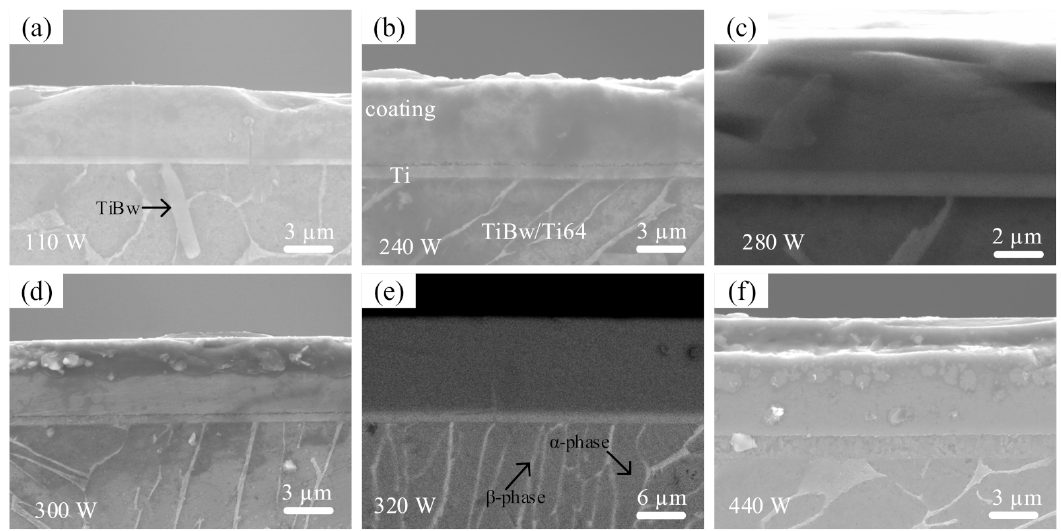
Figure 6. SEM micrographs of the Cr 2 AlC MAX phase coatings deposited by HiPIMS on TiBw/Ti6Al4V composite at P ave